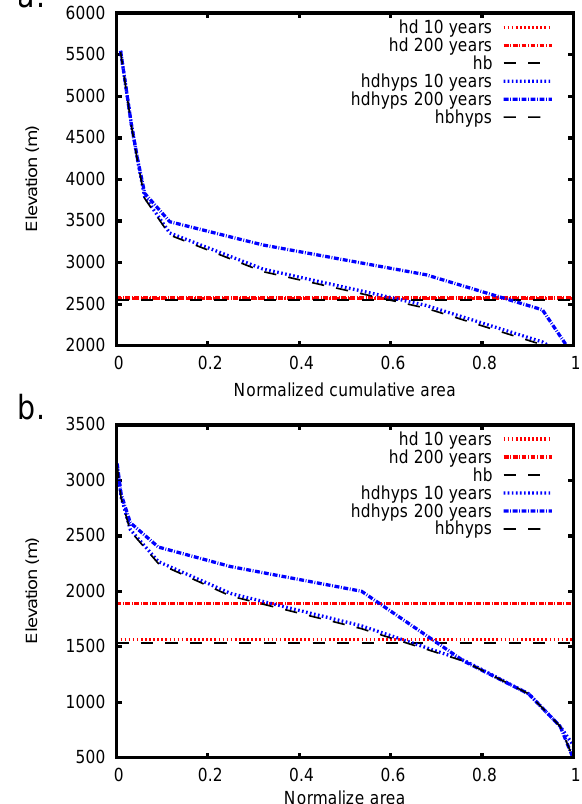
Figure 9. Elevation comparisons when the SG model is turned on (blue) or off (red) at different time steps using the parameter vec- tor nn9894. h d 10 years is the CG surface elevation after 10 years. h dhyps 10 years is the SG surface elevation. h b is the basal eleva- tion. (a) and (b) represent cases where the ELA is above and below the coarse grid surface